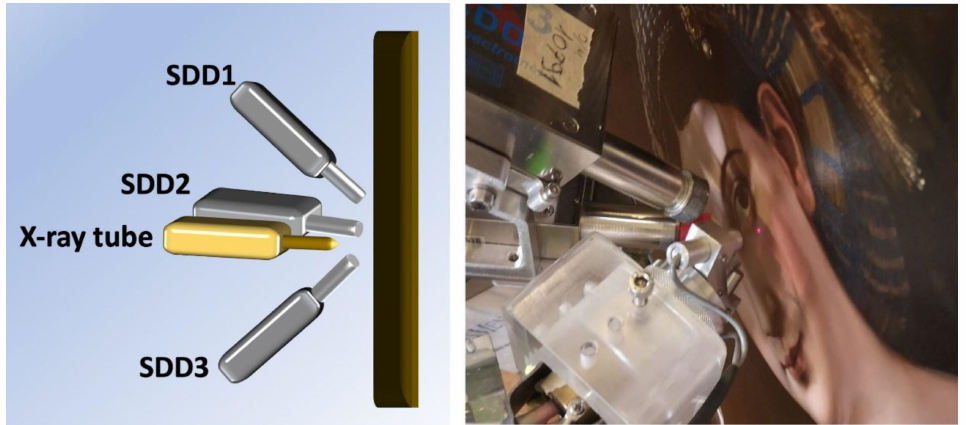
Figure 1. Schematic representation of the three-SDD MA-XRF scanner of INFN-CHNet ( left ). Picture of the measuring head taken during the acquisition of elemental maps on the Raffaello’s Fornarina, 80 × 60 cm 2 panel at Palazzo Barberini, Galleria Nazionale Arte Antica, Rome ( right ). Two of the three detectors are visible, as well as the two laser beams (which allow for the correct aiming of the point of